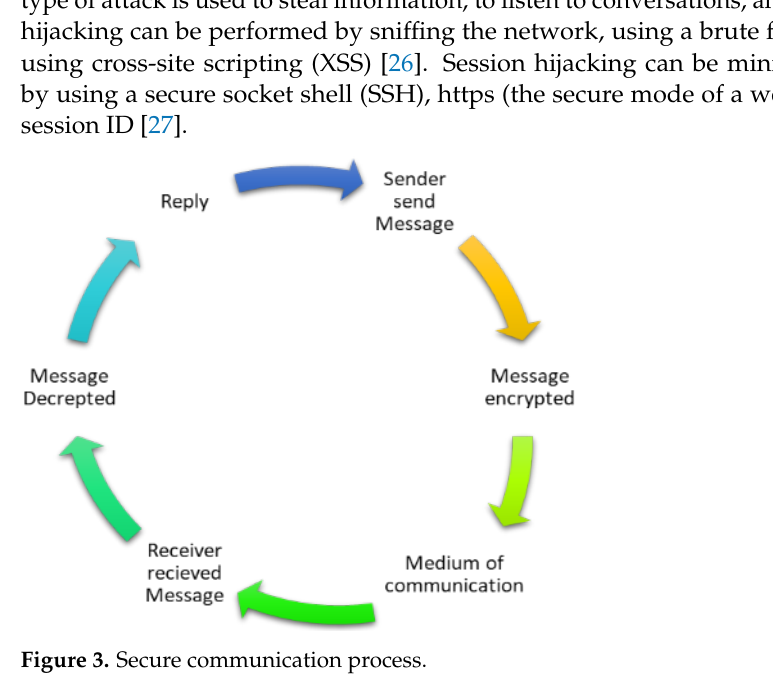
Figure 3. Secure communication process.